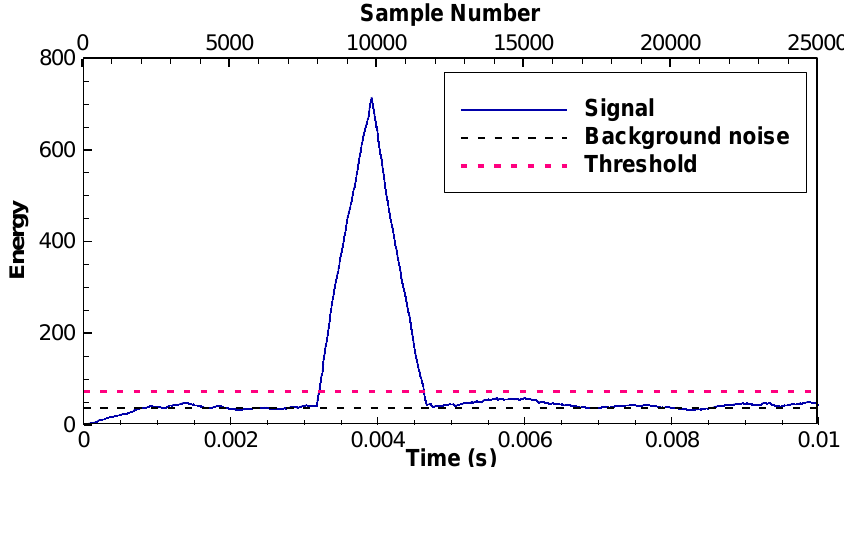
Figure 6. Correlation of a candidate signal that passes the JSATS